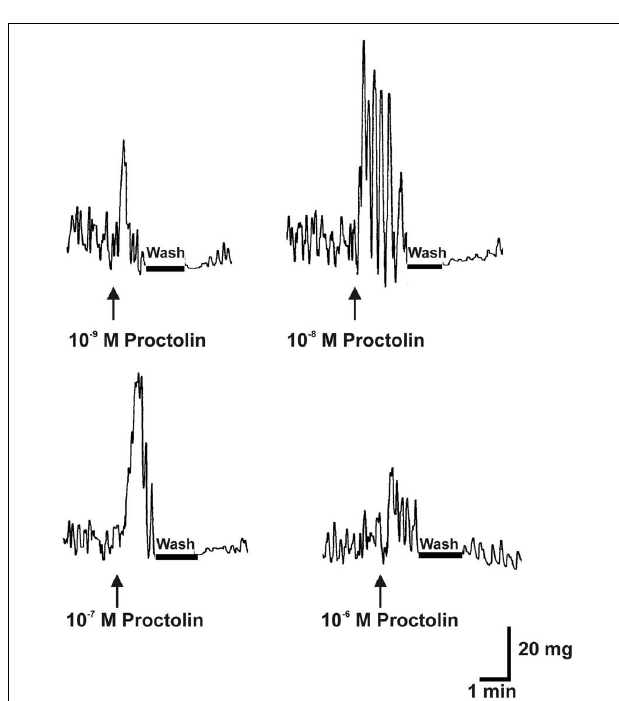
FIGURE 8 |The effects of proctolin on spontaneous contractions of the anterior midgut of fifth instar R. prolixus . The sample trace illustrates that proctolin leads to an increases in the frequency and amplitude of anterior midgut contractions. Upward arrows indicate the addition of peptide. Note that the induced contractions are decreased after washing in saline (bar). Similar results were obtained from seven preparations.